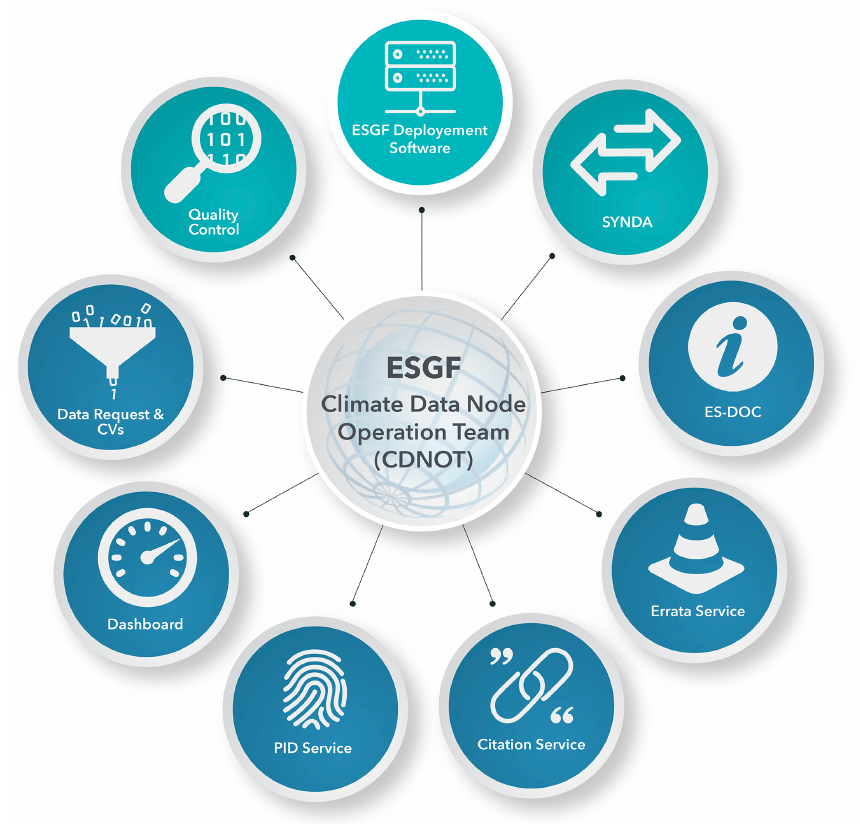
Figure 4. Schematic showing the software ecosystem used for CMIP6 data delivery. Note the darker blue bubbles are those that represent the value-added